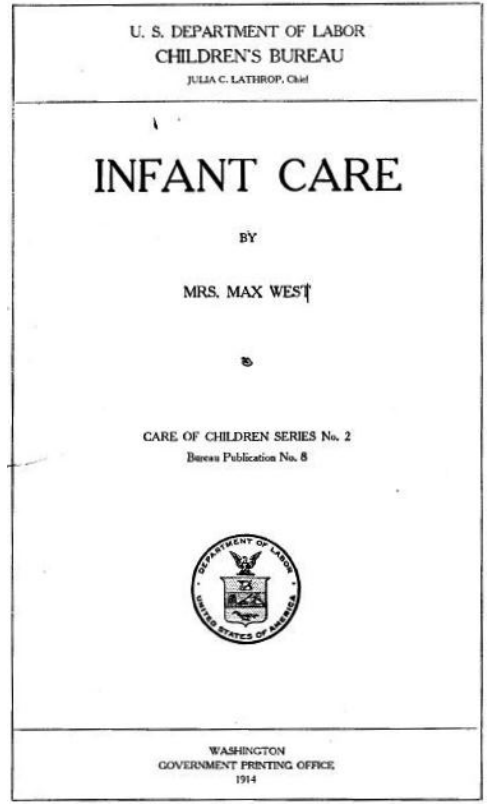
Figure 1. Cover of First Edition of Infant Care, published in 1914.